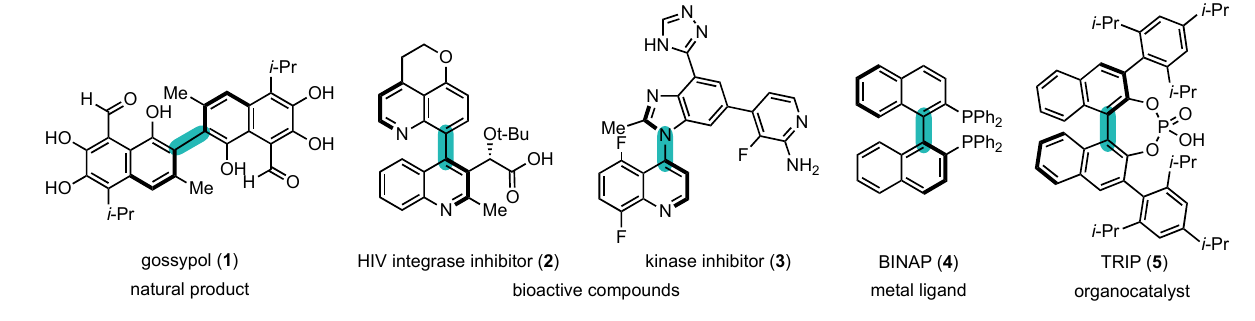
Figure 1. Atropisomers: examples and their fields of application.